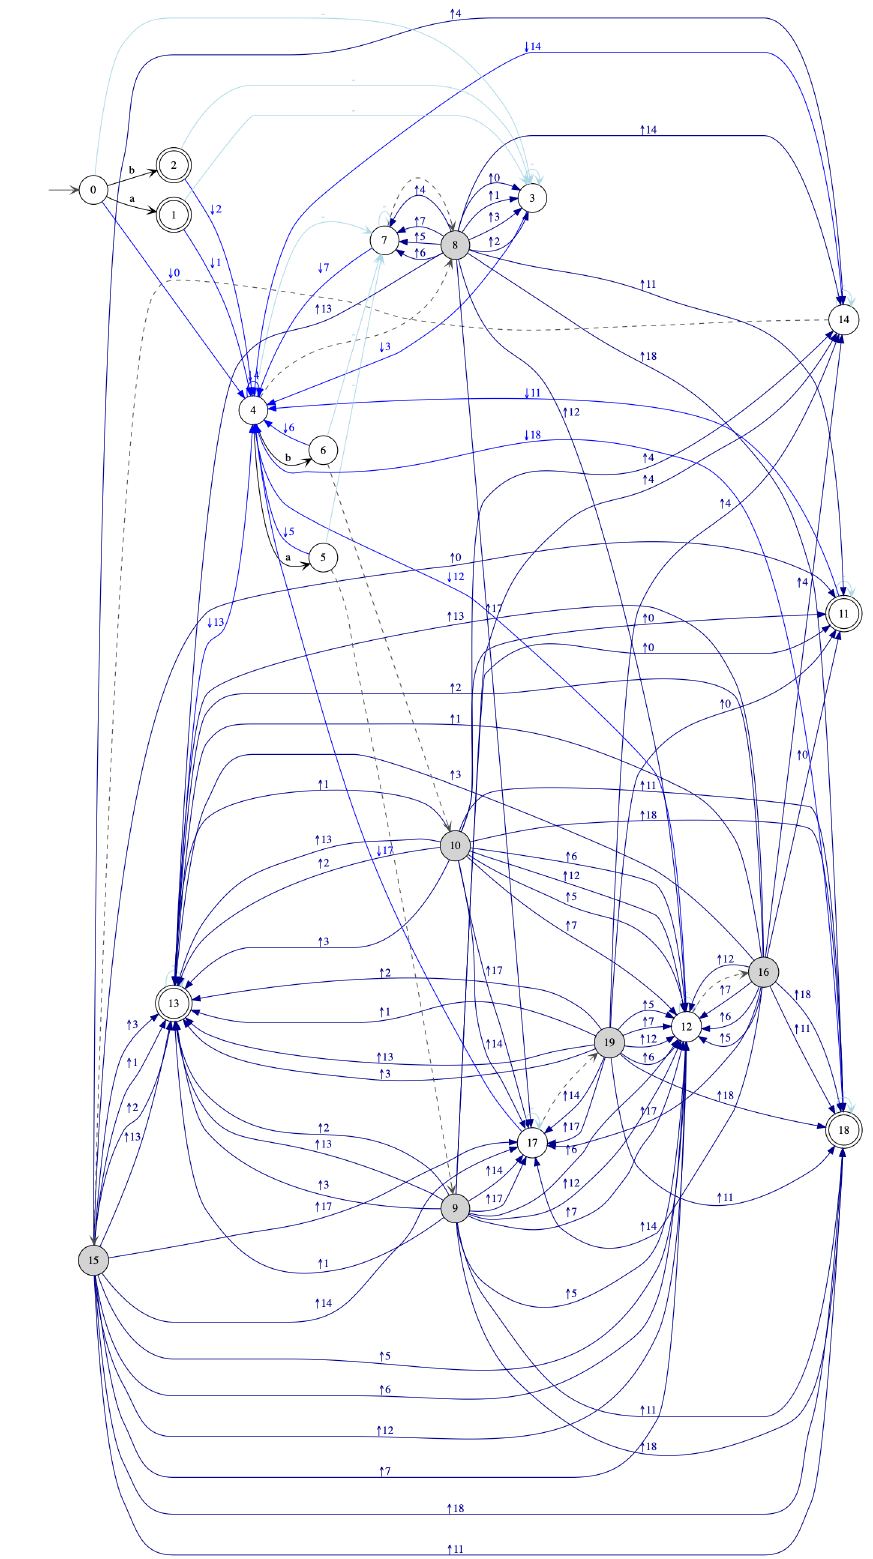
Figure A4. Determinization of NWA from stepwise hedge automaton: det ( nwa ( step ( ch ∗ ( a + b ))))